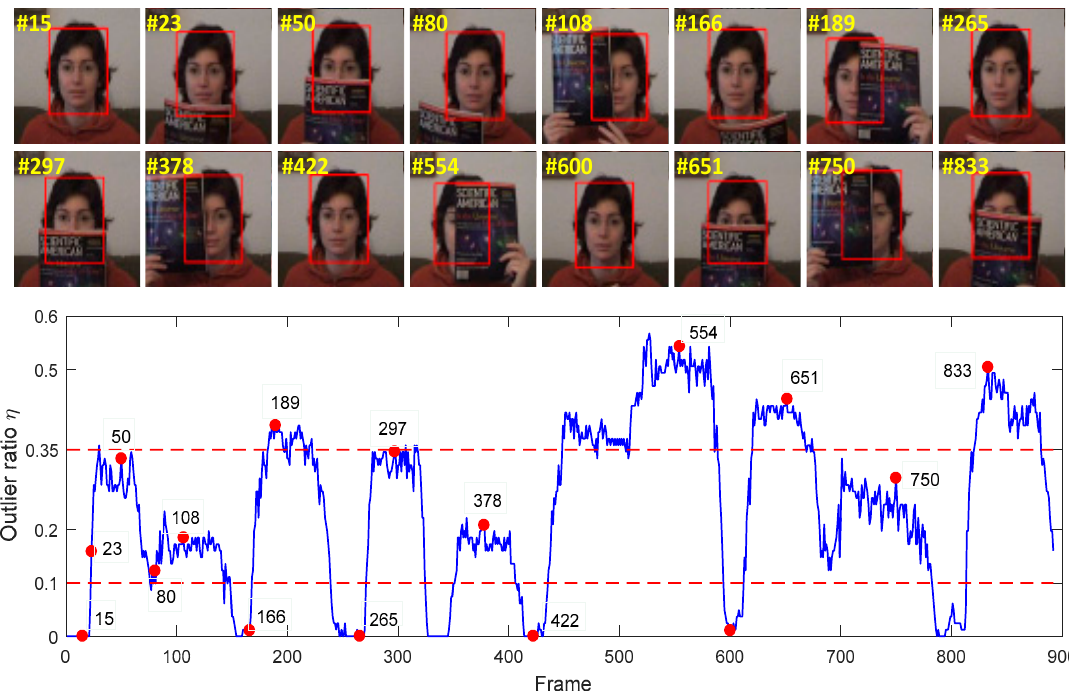
Figure 3. An illustration of the variation of the outlier ratio η on the FaceOcc1 sequence. In the bottom plot, the blue curve reflects the variation of the outlier ratio on each frame, and the two horizontal red dashed lines are the predefined thresholds (set to 0.1 and 0.35 in our approach). We also mark the key frames and their indices with red points in the plot, which are correspondingly shown at the top of the plot.